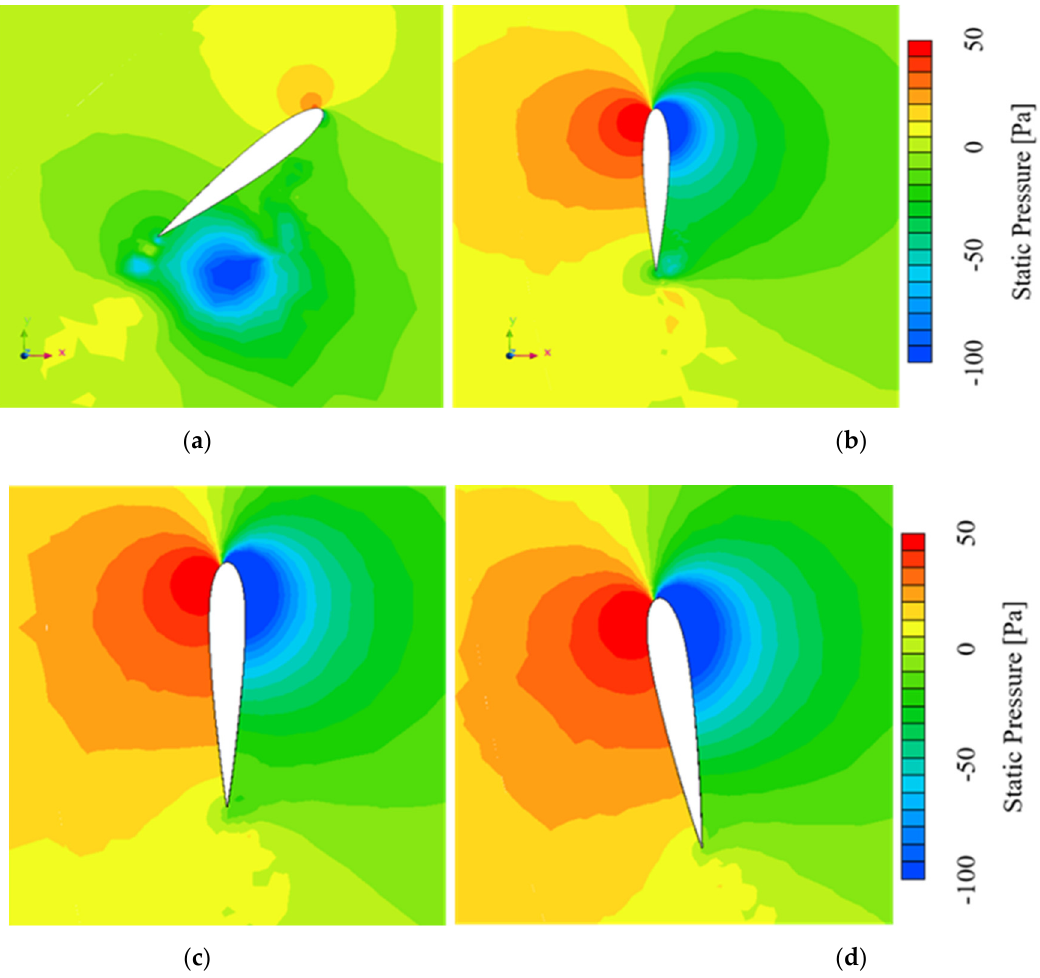
Figure 16. Pressure distribution with respect to the blade rotation at a TSR of 3.5: ( a ) θ = 45°, ( b ) θ = 90°, ( c ) θ = 100°, ( d ) θ = 110°.